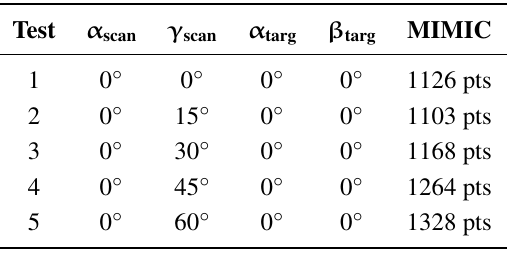
Table 2. The impact of vertical scanner rotations on the number of pulses striking a parallel 2 m × 1 m target at a horizontal range of 5 m at 50 km/h.